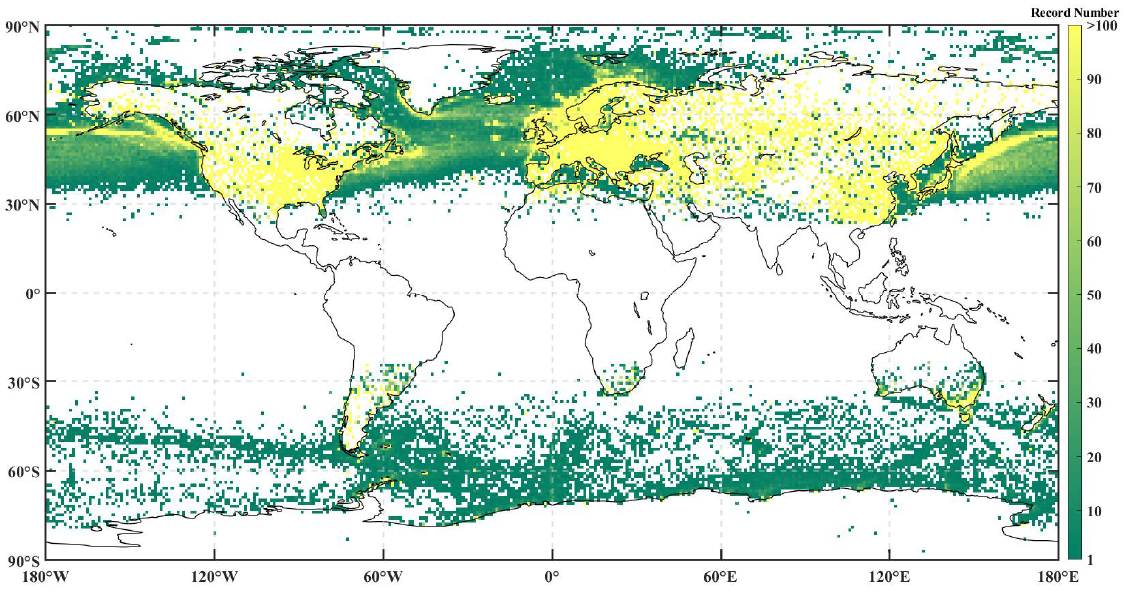
Figure 1. The spatial distribution of NCEP ADP precipitation samples at 1° × 1° resolution from 1978 to 2007. For each grid box, the value represents the total number of positive precipitation events from land stations or ocean ships/buoys. Only samples after quality control (refer to Section 2.4) are used.